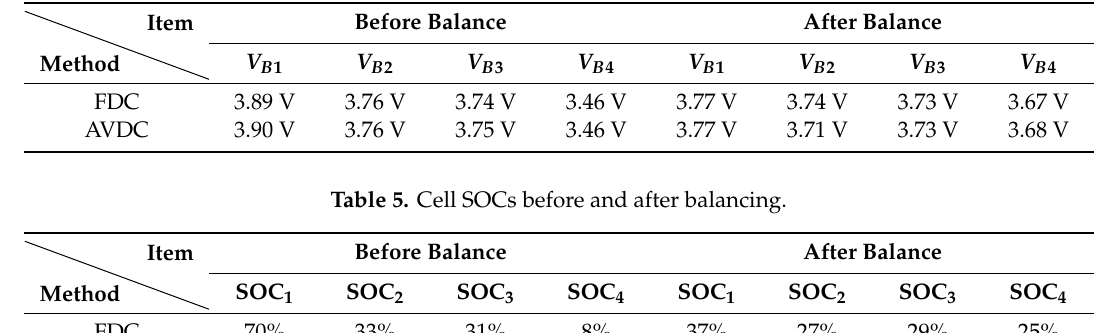
Table 4. Cell voltages before and after balancing.